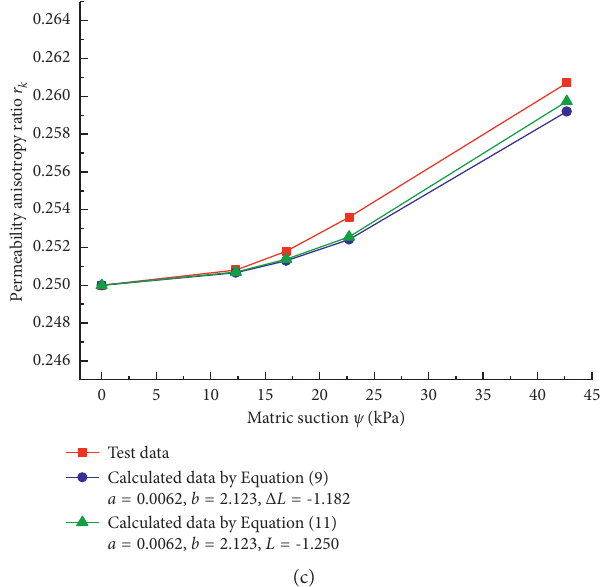
Figure 9: Relationship between measured and calculated unsaturated permeability anisotropy ratio and matrix suction for three types of soils. (a) Cass sandy loam [35], (b) Fort Collins clay loam [35], and (c) Xi’an Q 3 undisturbed loess